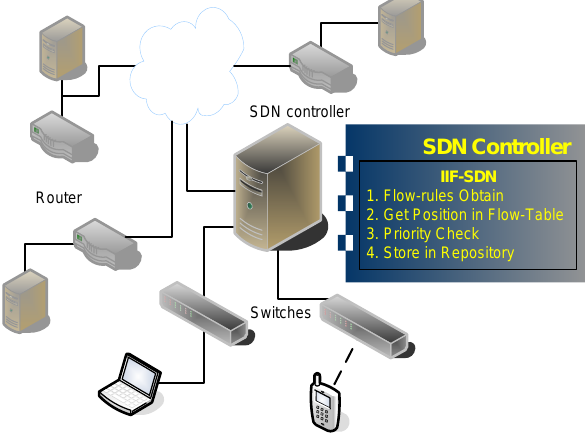
Figure 10. SDN domain (hosts, switches, controller).